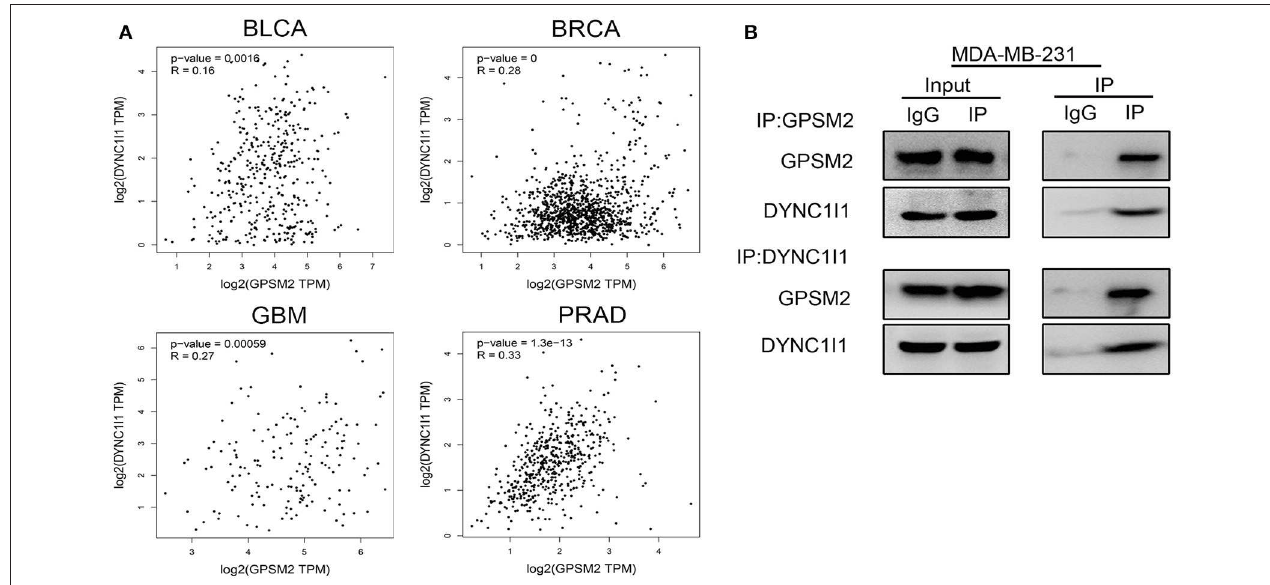
FIGURE 3 | GPSM2 interacts with DYNC1I1 in breast cancer cells. (A) GEPIA website analysis the correlation between GPSM2 and DYNC1I1; (B) Immunoprecipitation assay was performed to detect the interaction between GPSM2 and DYNC1I1 in breast cancer MDA-MB-231 cells.